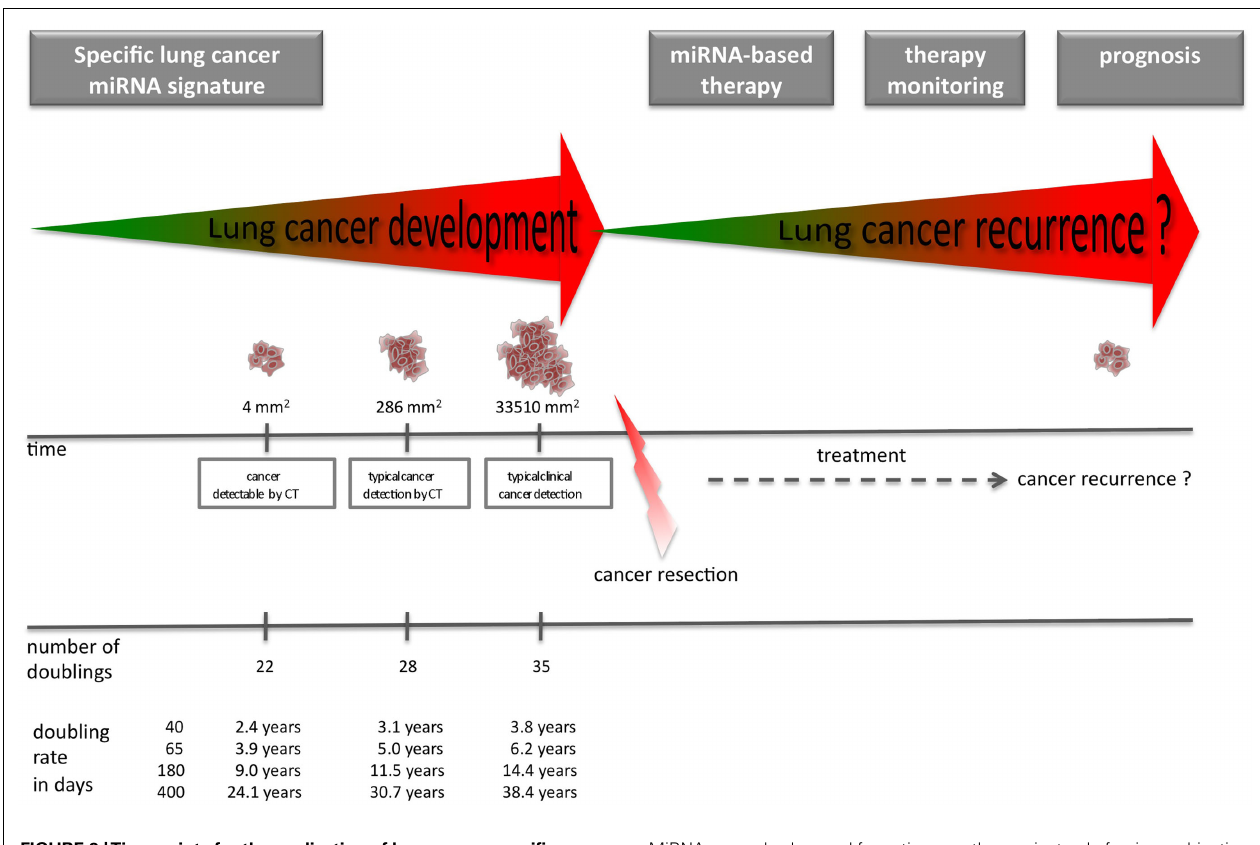
FIGURE 2 |Time points for the application of lung cancer specific miRNAs. Specific tumor-associated miRNA signatures might detect the tumor prior to CT. After cancer resection and/or therapy (radiotherapy or chemotherapy) miRNAs might help in therapy monitoring and prognosis.